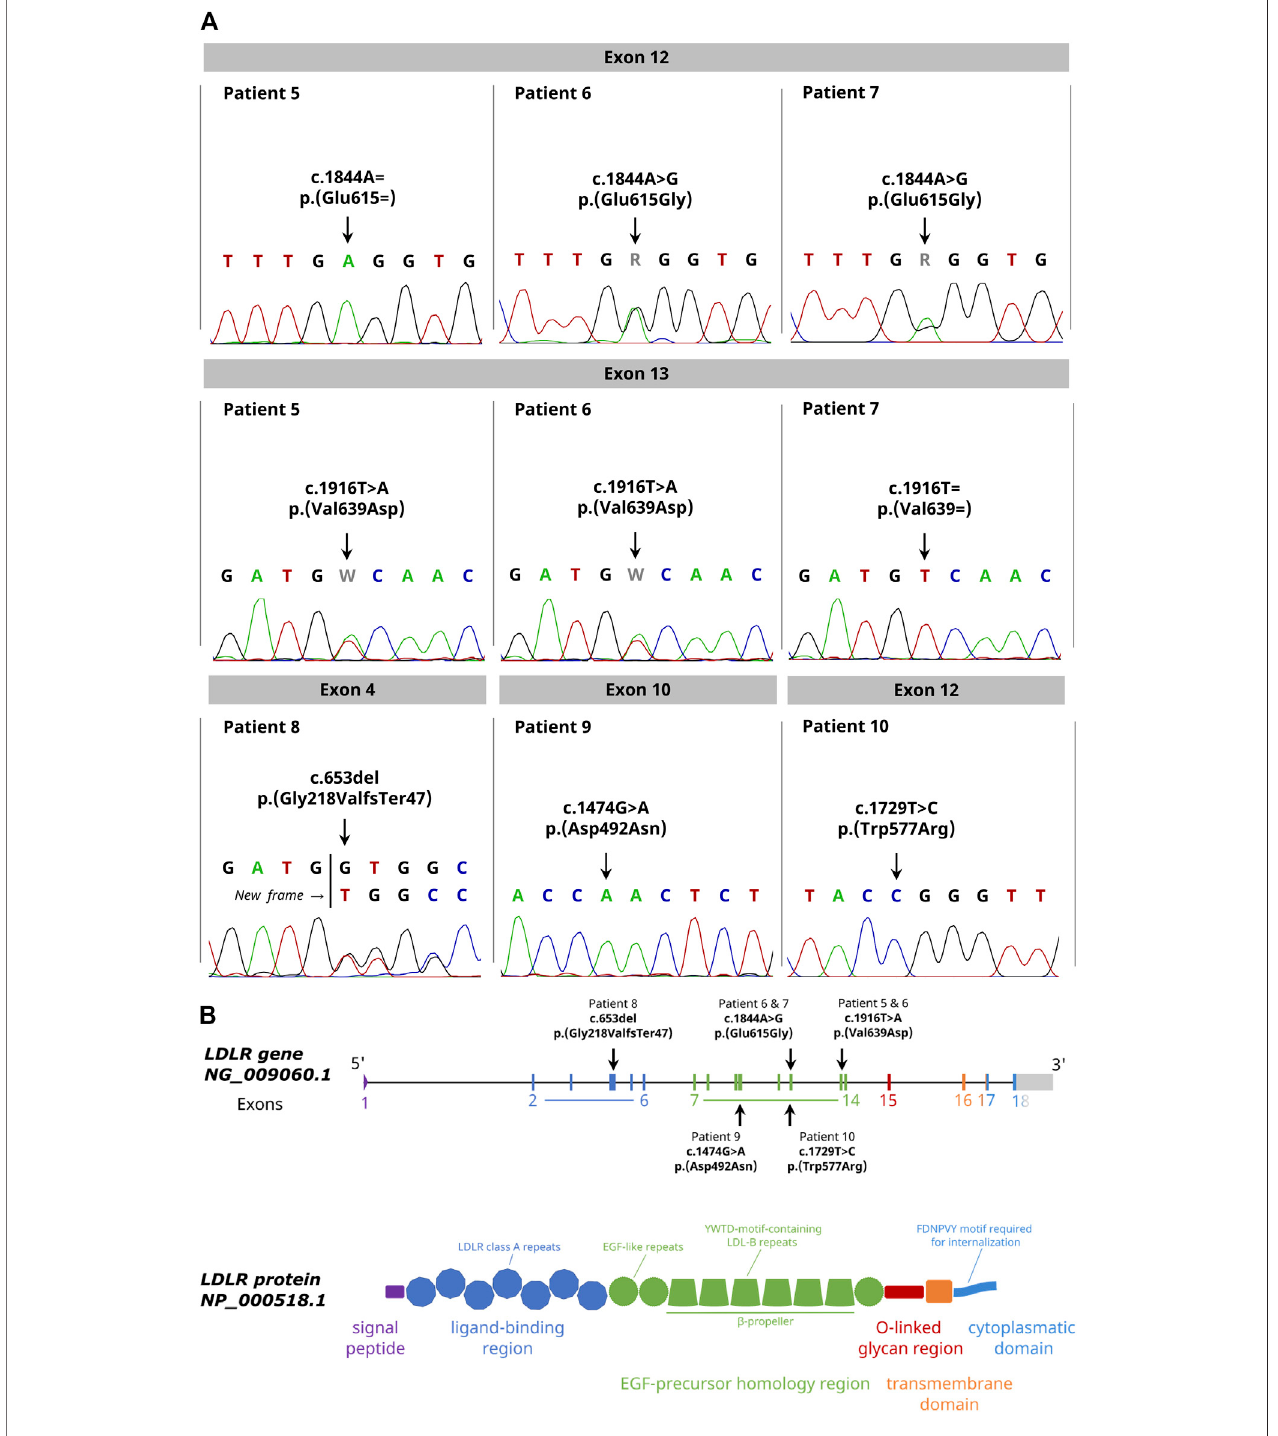
FIGURE2| Detection ofunknown pathogenic LDLRvariants inFH patients withtheNanopore Sequencing work fl ow. (A) Sanger sequencing results con fi rming all identi fi ed variants with indicated change on DNA and protein level. (B) Graphical illustration showing the genomic and domain structure of the LDLR and the location of the identi fi ed variants within the LDLR gene. The exons and the corresponding protein domain are indicated by the same color.